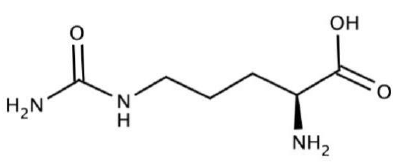
Figure 1. Chemical structure of L -citrulline.